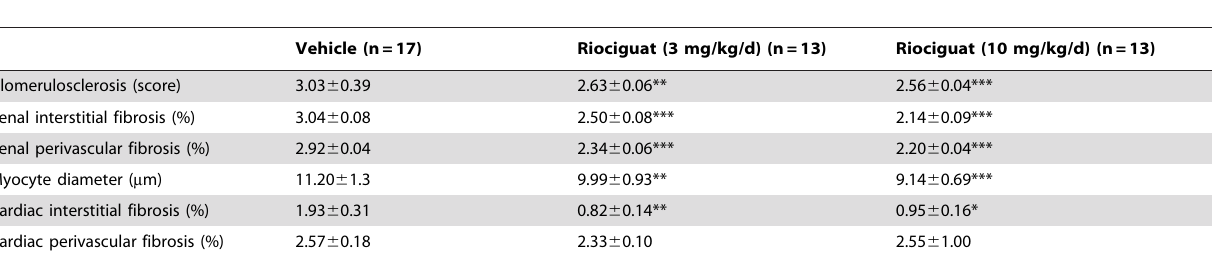
Table 5. Histopathological evaluation of the hearts and kidneys from the vehicle- and riociguat-treated Dahl/ss rats maintained on a high-salt diet.